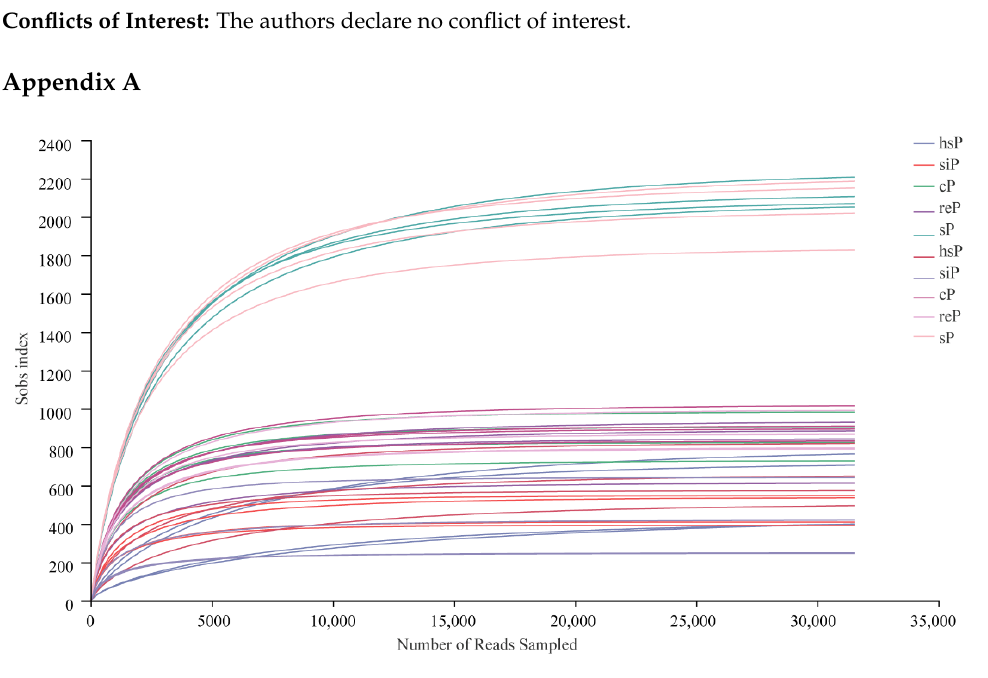
Figure A1. The rarefaction curves. The number of observed ASVs gradually plateaued as the sequencing depth increased, which demonstrates that each sample had sufficient ASVs to reflect the maximum level of bacterial